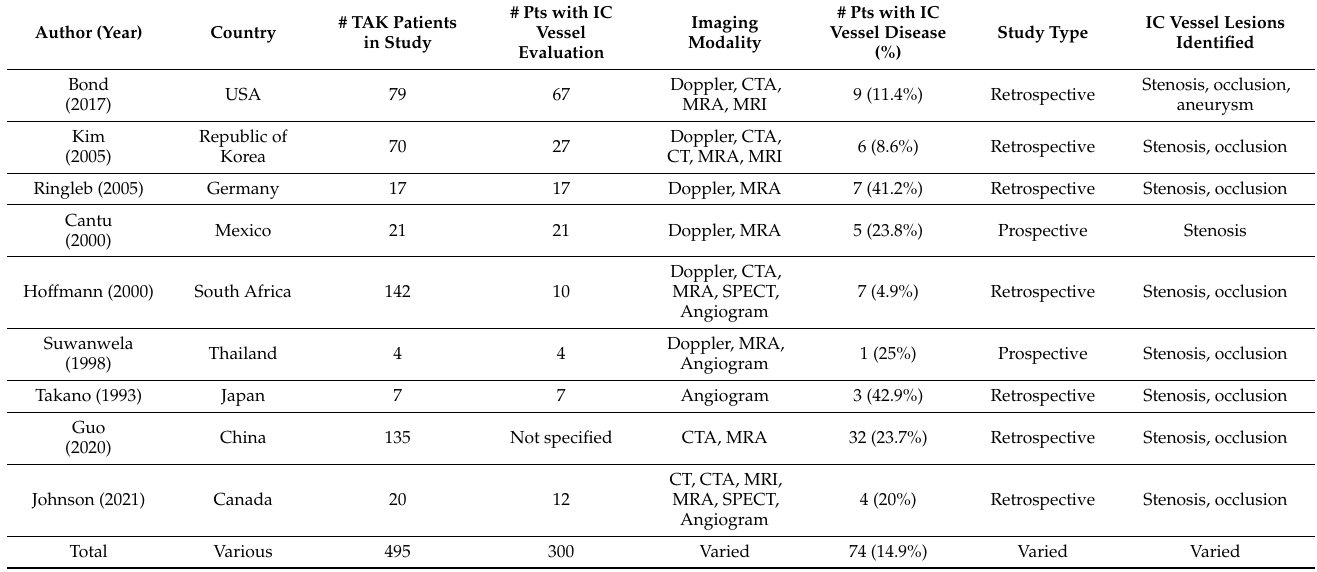
Table 4. Intracranial vasculitis in the TAK literature